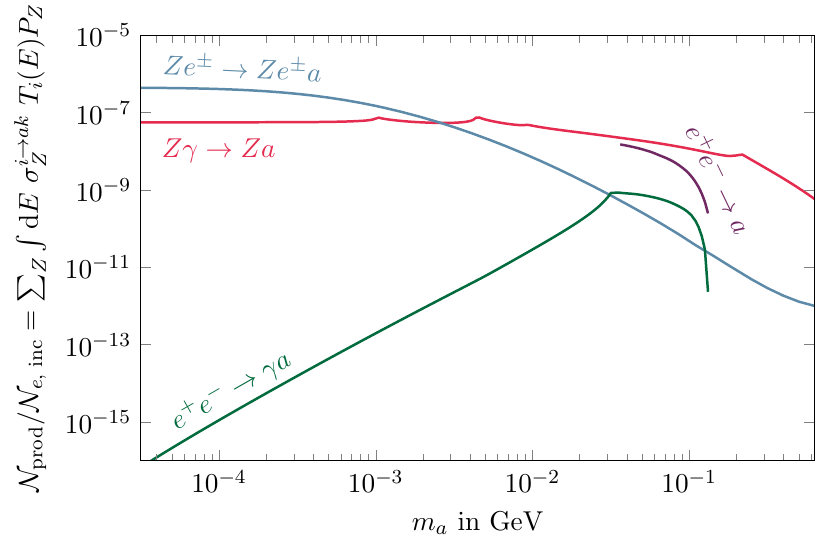
R d E σ i → ak T i ( E ) P Z for Z Z